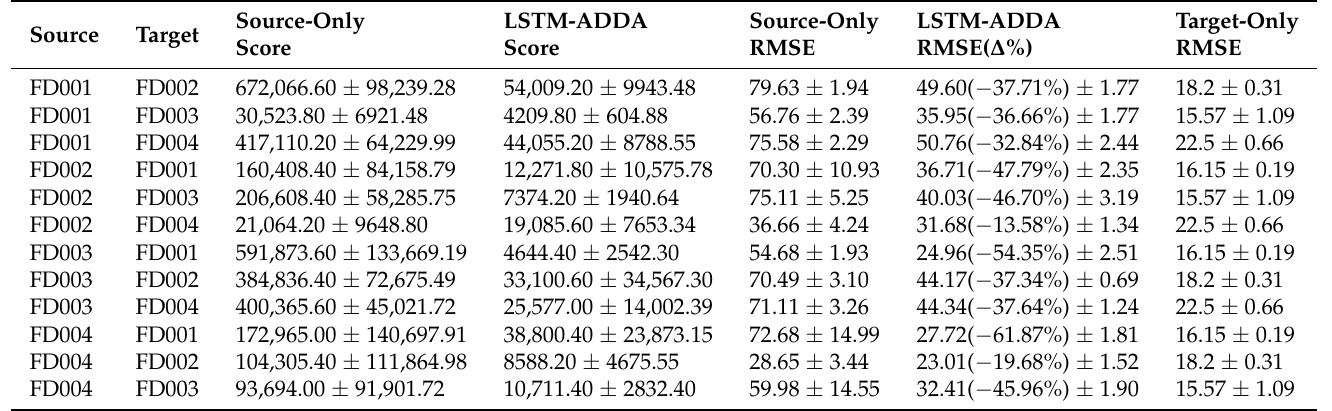
Table 3. Score and RMSE comparsion between Source-Only, Target-Only and LSTM-ADDA. ( ∆ % denotes the percentage of evaluation metric improvement. ± denotes the standard